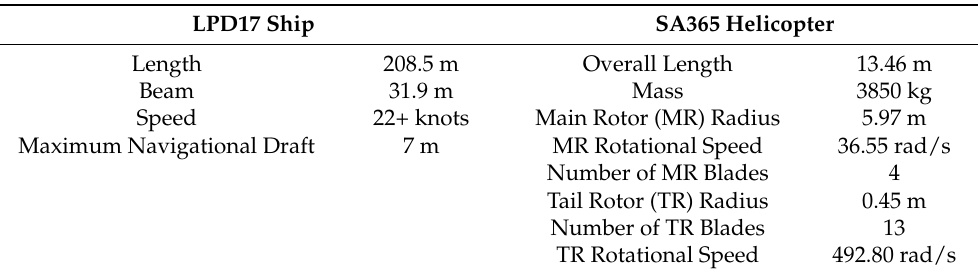
Table 2. Main parameters of CG47 ship and UH60 helicopter.